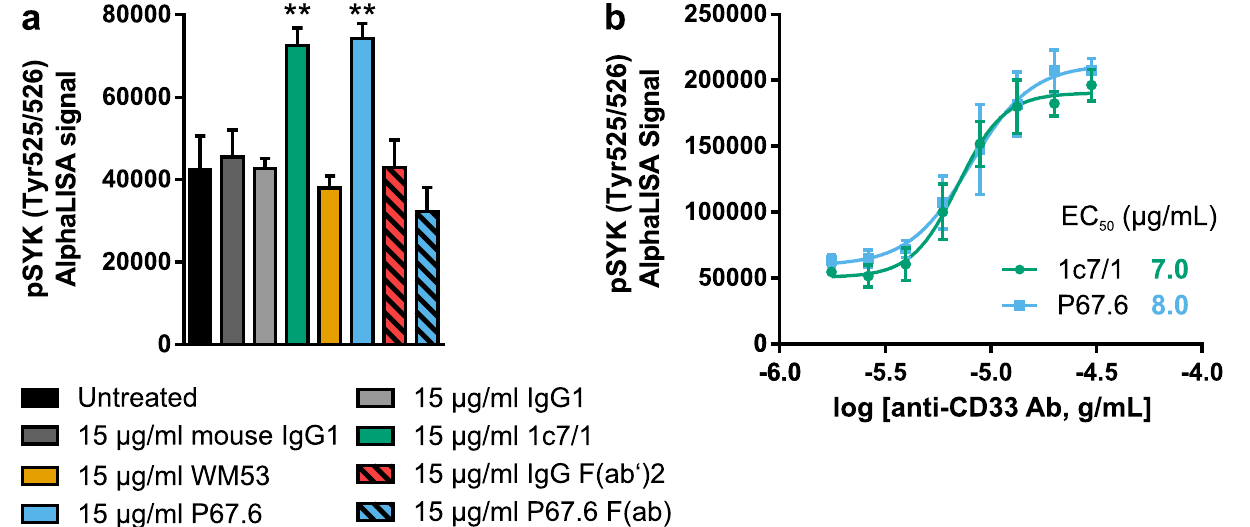
Figure 3. pSYK detection in CD33M-DAP12 cell lines. ( a ) pSYK detection in CD33M-DAP12 reporter cells treated with CD33-specific antibodies. Addition of CD33 antibodies P67.6 and 1c7/1 resulted in increased pSYK levels, whilst P67.6 F(ab), WM53 as well as the different isotype IgG1 control antibodies did not show any change in endogenous pSYK levels. ( b ) 1c7/1 and P67.6 dose–response curve in CD33M-DAP12 reporter cells. Addition of CD33 antibody clones 1c7/1 and P67.6 resulted in an increase in endogenous pSYK levels measured 30 min after the treatment. Data are presented as mean ± or + SD; ** p ≤ 0.01 compared to untreated determined by one-way ANOVA analysis followed by Dunnett’s post hoc